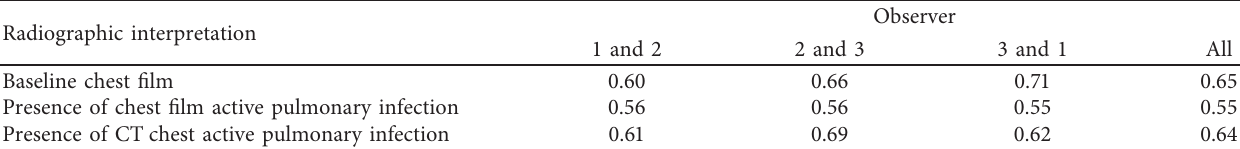
Figure 4: Receiver operating characteristic curve comparing the absolute neutrophil count with radiologic active pulmonary infection as predictors of pulmonary infection. Table 3: Interobserver agreement in chest film and CT chest